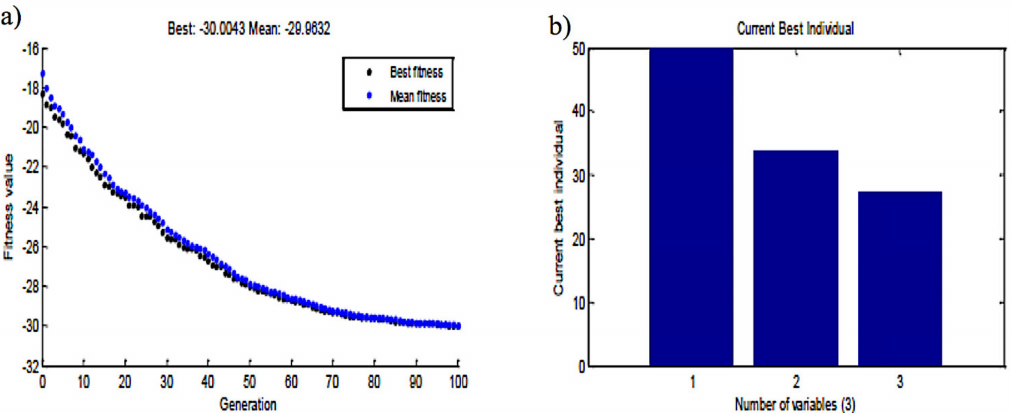
Figure 2. Genetic algorithm showing generations till the optimum results obtained, the optimum conditions of the nanoantibiotic components: ( a ) Current generation vs. fitness values; ( b ) Current best individual vs. number of